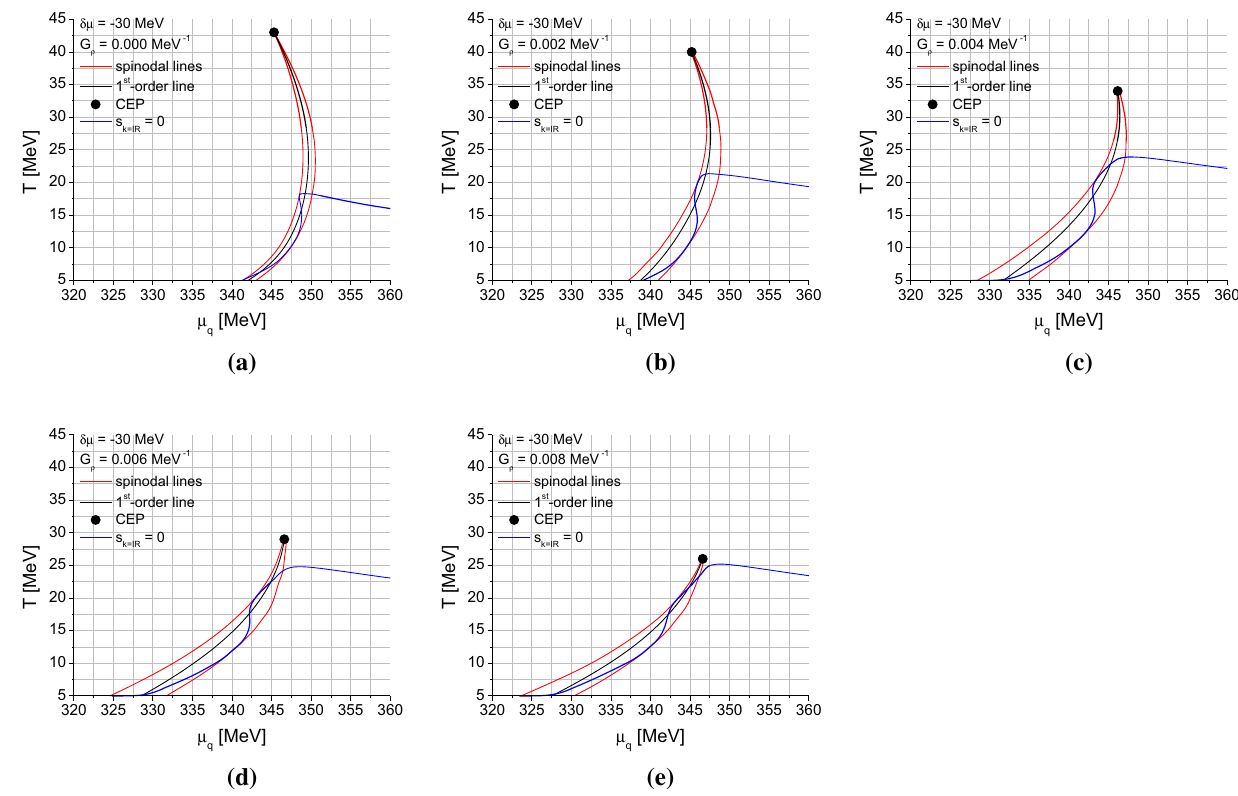
Fig. 5 First order phase transition of the QM model with δμ = − 30MeV,forincreasing G ρ withfixed G ω = 0.Thered,blackandblue lines are the spinodals, first order phase transitions and the s k = IR = 0